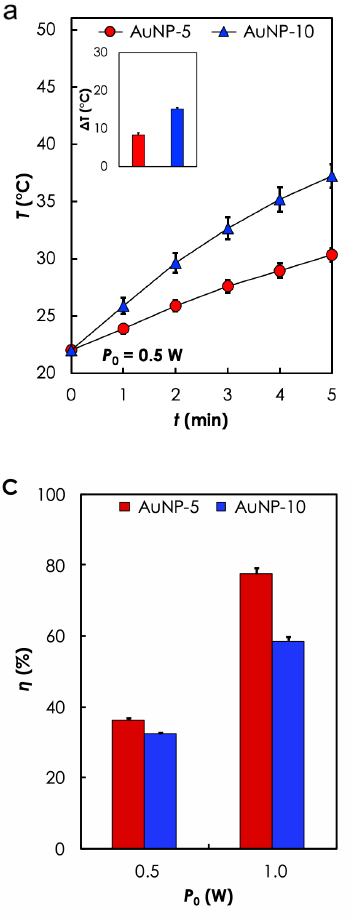
Figure 4. Photothermal heating in aqueous solution results. Temporal response curves for the different samples when ( a ) P 0 = 0.5 W and ( b ) P 0 = 1.0 W. ( c ) Conversion efficiency ( η ) as a function of P 0 for different P 0 W. Exposure time: t = 5 min.